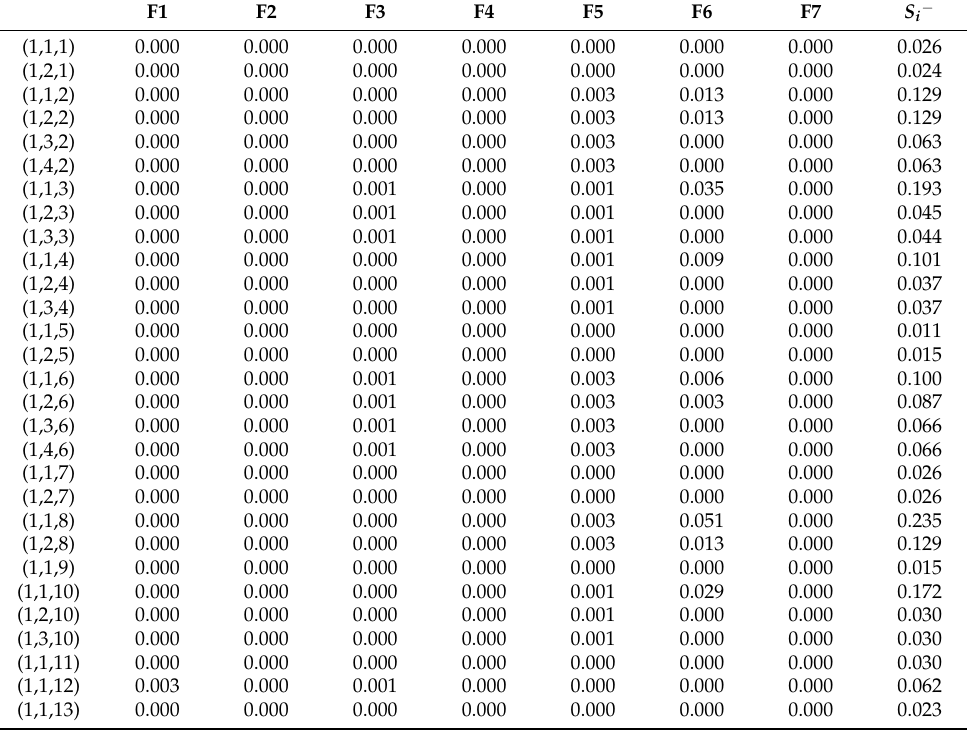
Table A11. Total separation of eligible operations from the anti-ideal scenario—1st